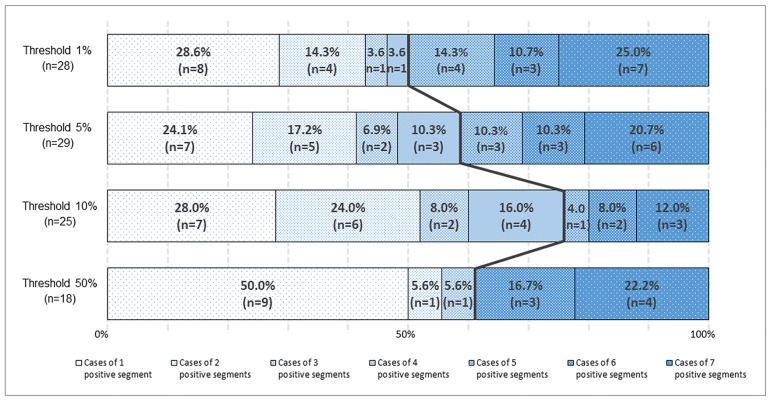
Distributions of cases with heterogeneous PD-L1 expression and varying numbers of PD-L1-positive segments.The left side of the black line indicates the proportions of cases where negative segments account for ≥50.0% of the total number of segments within the cores and the right side of the black line indicates the proportions of cases where positive segments account for >50.0% of the total number of segments within the cores. At any of the thresholds, ≥50.0% of the total number of segments within the cores were negative in no fewer than 50.0% (range, 50.0–76.0%) of cases with heterogeneous PD-L1 expression.